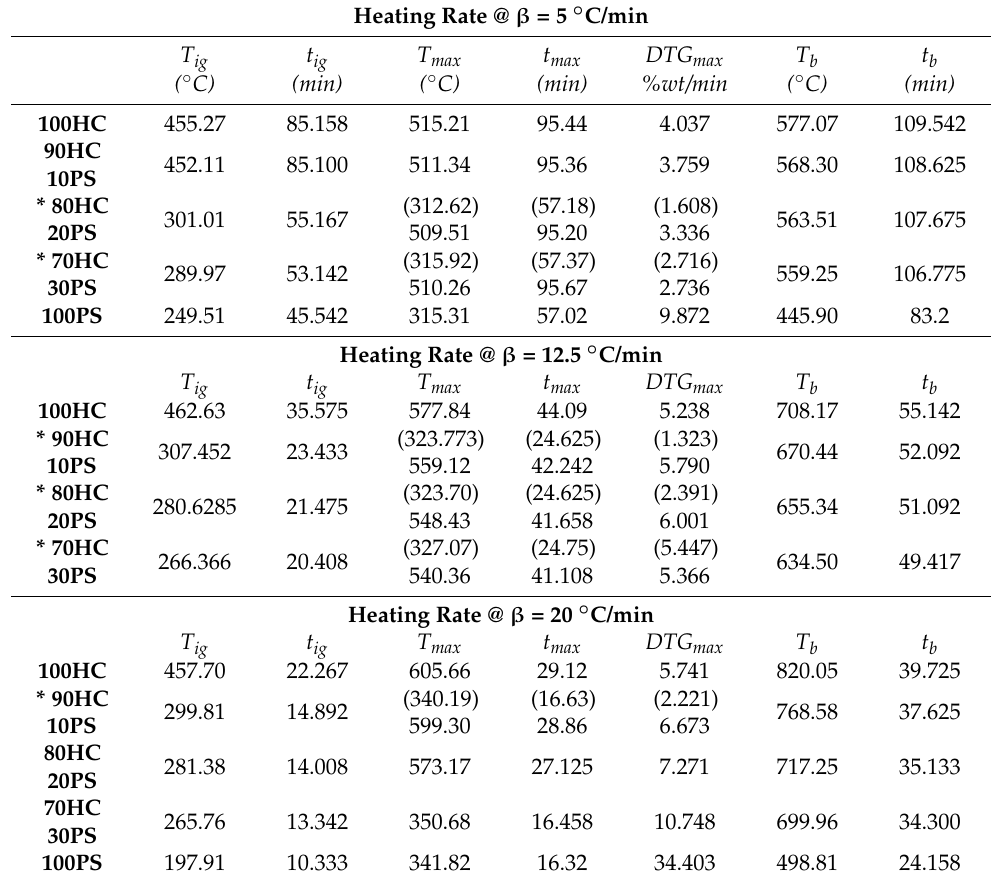
Table 3. Important points on TG and DTG curves for various fuel blends in air